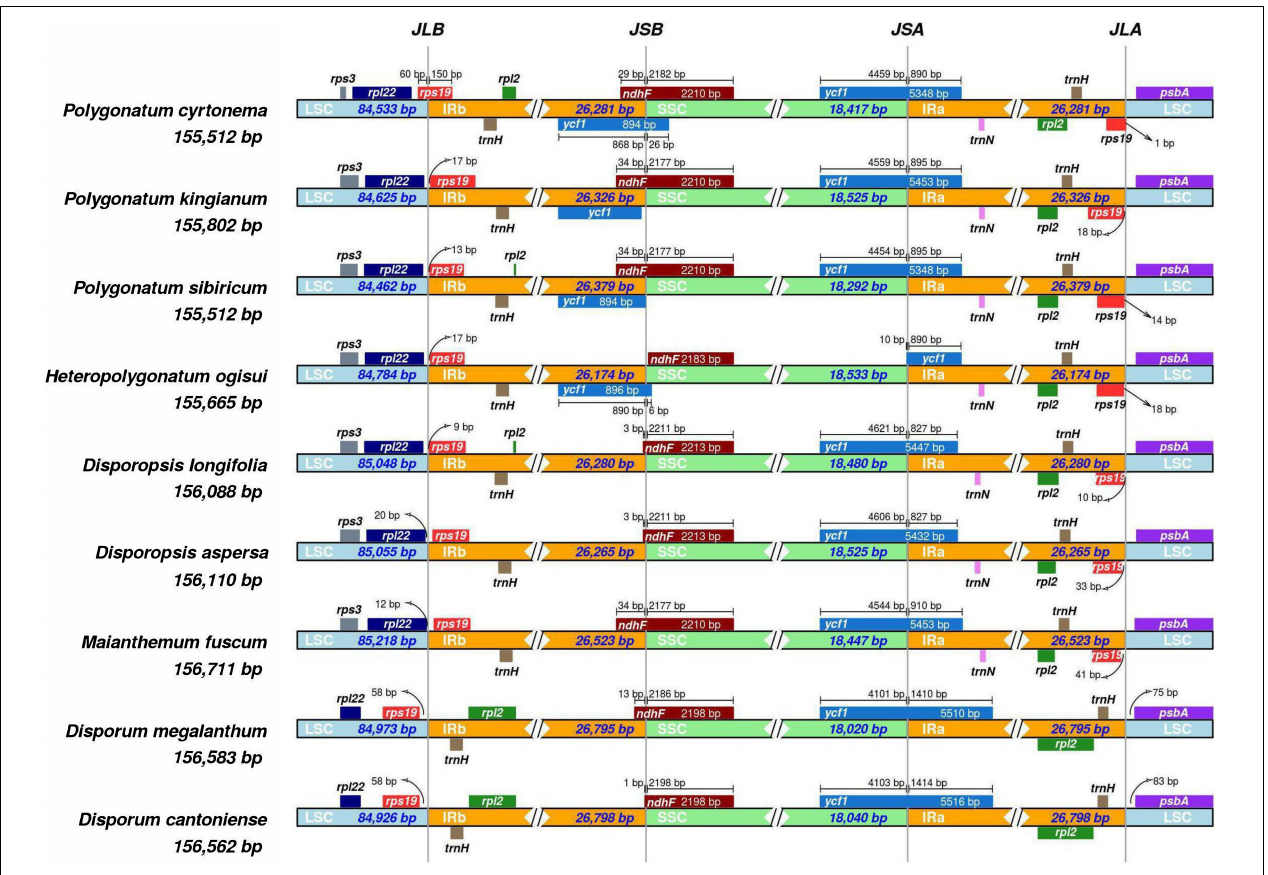
FIGURE 2 | Comparisons of the borders of LSC, SSC, and IRa/b regions among the Polygonatum , Heteropolygonatum , Disporopsis , Maianthemum , and Disporum.